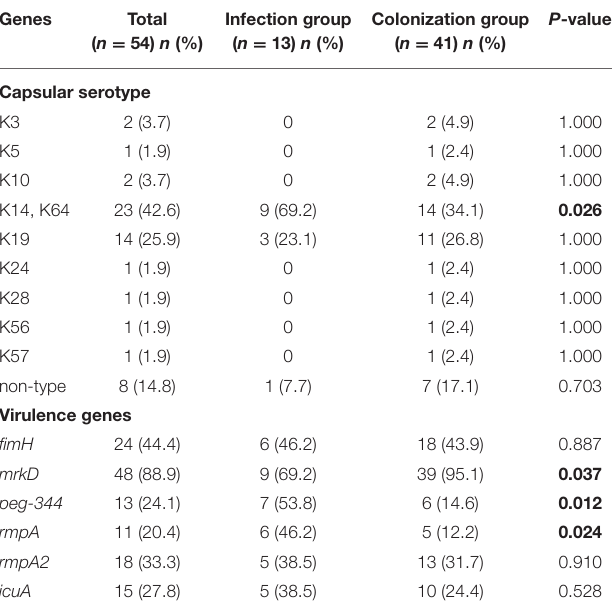
Bold values in the P-value column indicated statistical significance.